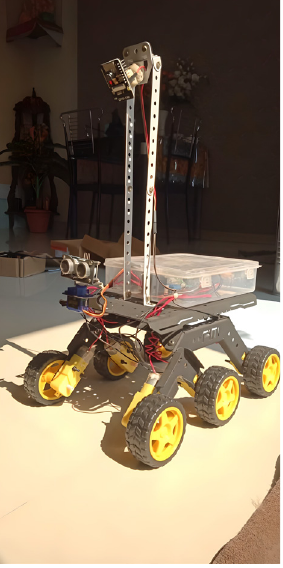
Figure 4. The Rover with ESP32 CAM implemented